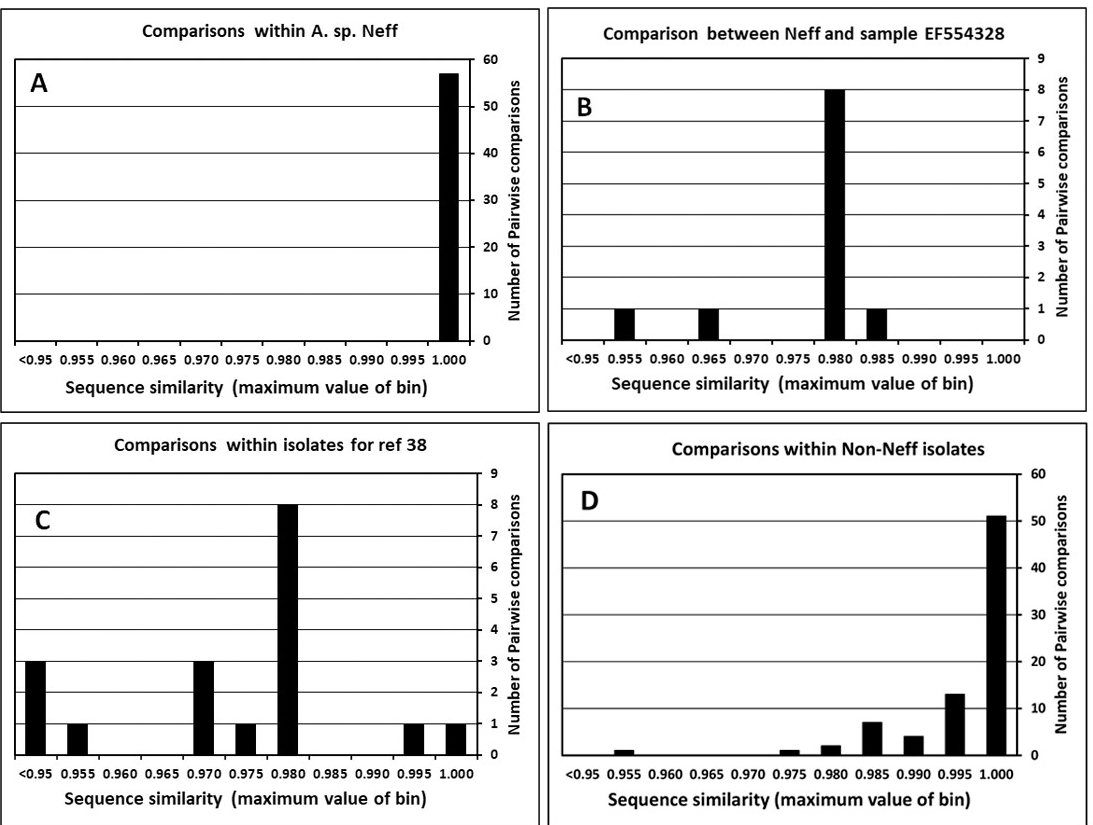
Figure 1. Pairwise sequence similarity for multiple sequences of the same 18S rRNA gene within an ATCC isolate: ( A ) Pairwise comparisons between independent determinations of the 18S rRNA genes of A. castellanii Neff; ( B ) Pairwise sequence similarity between various 18S rRNA gene sequences from Neff isolates and the putative Neff isolate represented by GenBank acc # EF554328; ( C ) Pairwise sequence similarity when comparing sequences from [41] with equivalent sequences from the same ATCC/CCAP isolates determined in other studies; ( D ) Pairwise sequence similarities for sequences of the 18S rRNA genes within an ATCC/CCAP isolate with multiple sequence determination, excluding the results from Figure 1A–C.